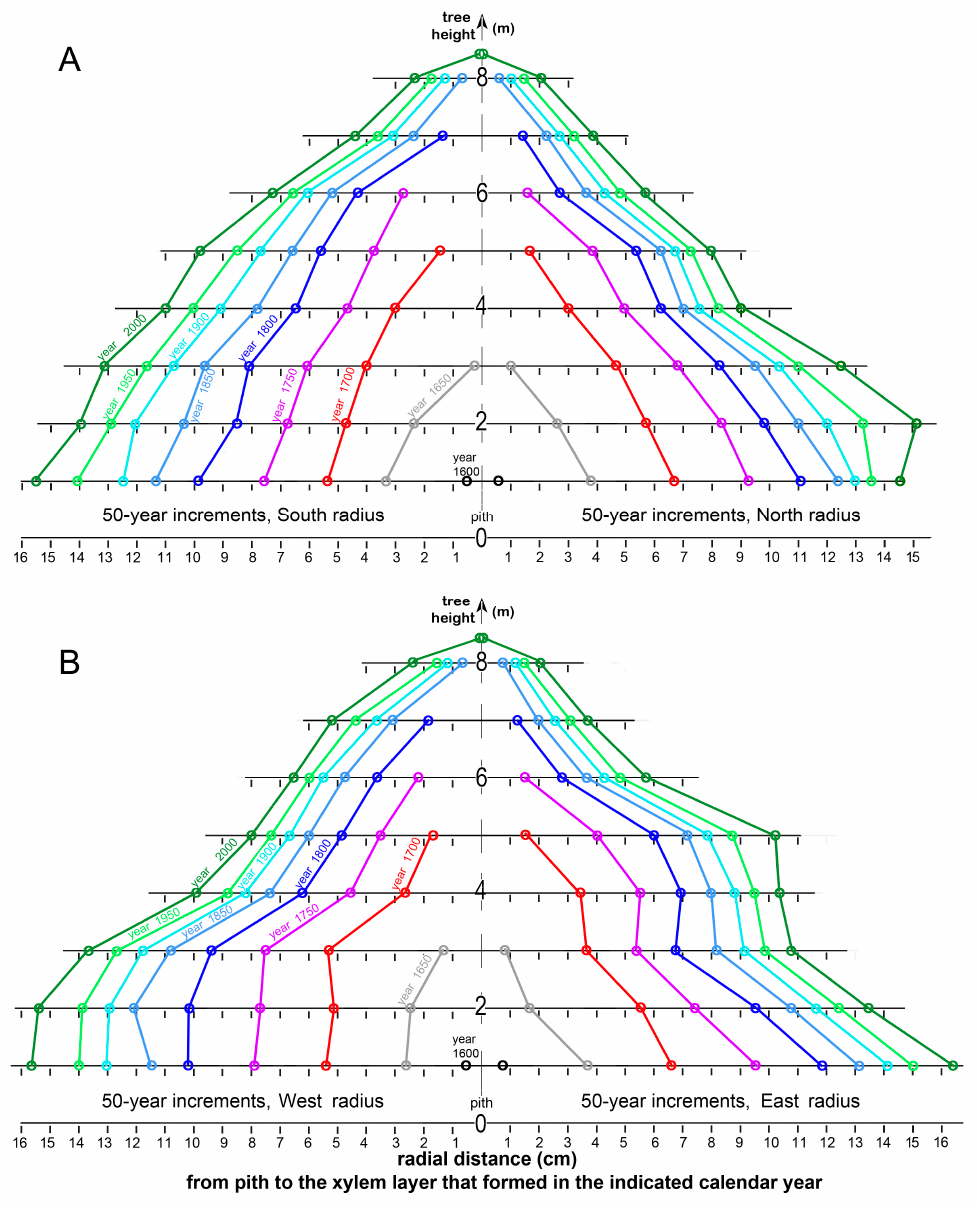
Figure 14. The progression of gišogenetic growth over 50-year periods on ( A ) the south and north sides and ( B ) the west and east sides of the trunk of tree 1311 as the tree increased in height.